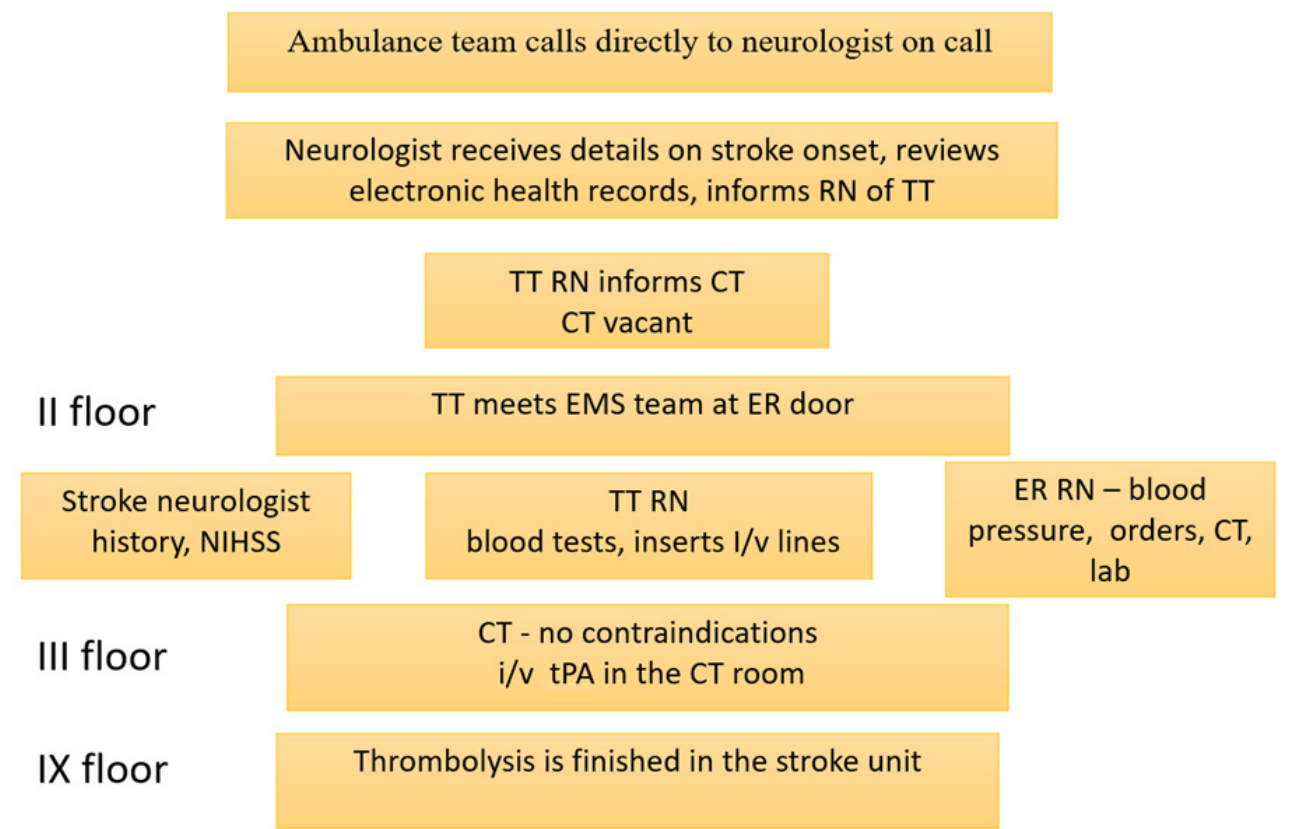
Figure 1. Thrombolysis protocol at WTCH 2014–2021. RN—registered nurse, TT—thrombolysis team, ER—emergency room, CT—computed tomography, EMS—emergency medical team, ambulance, tPA—tissue plasminogen activator, i/v—intravenous, NIHSS—National Institute of Stroke Scale